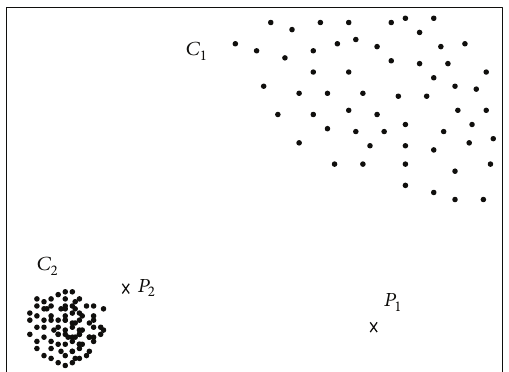
Figure 6: Nearest neighbor based